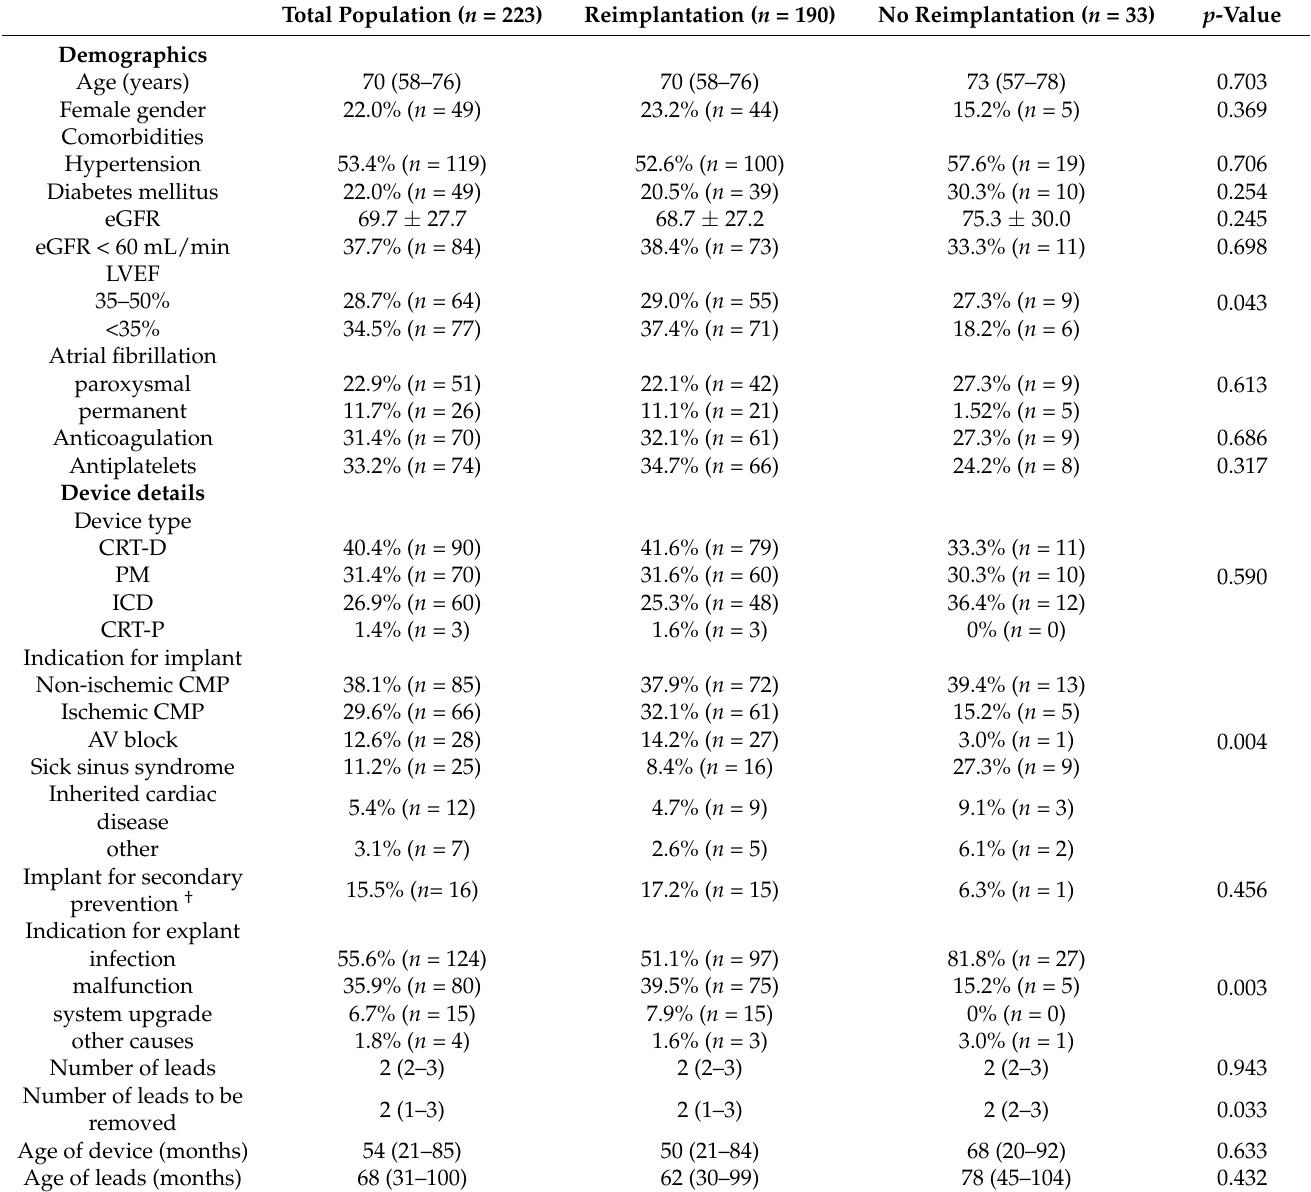
Table 1. Baseline characteristics of the included